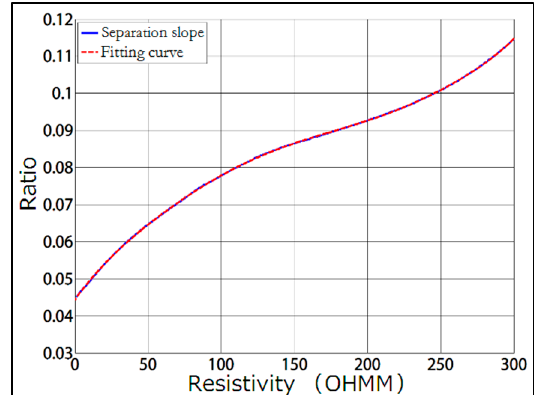
Figure 6. Linear coe ffi cient curve fi tt ing.